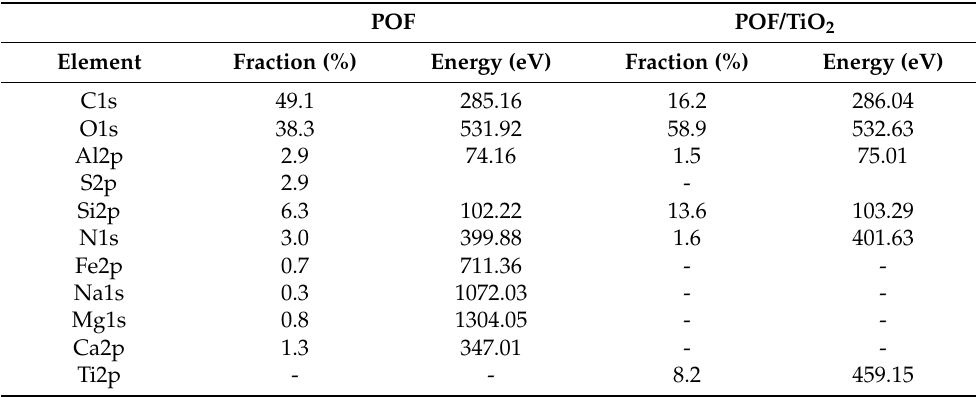
Table 1. Composition of POF and POF/TiO 2 from XPS